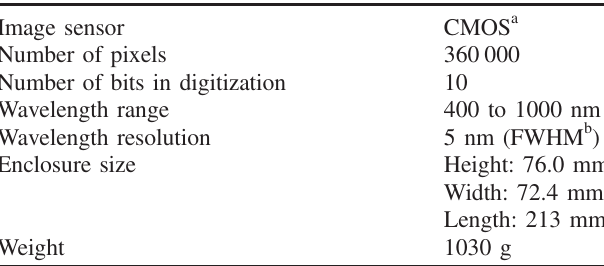
TABLE II. Specifications of the hyperspectral camera NH-KE3 used in this study.